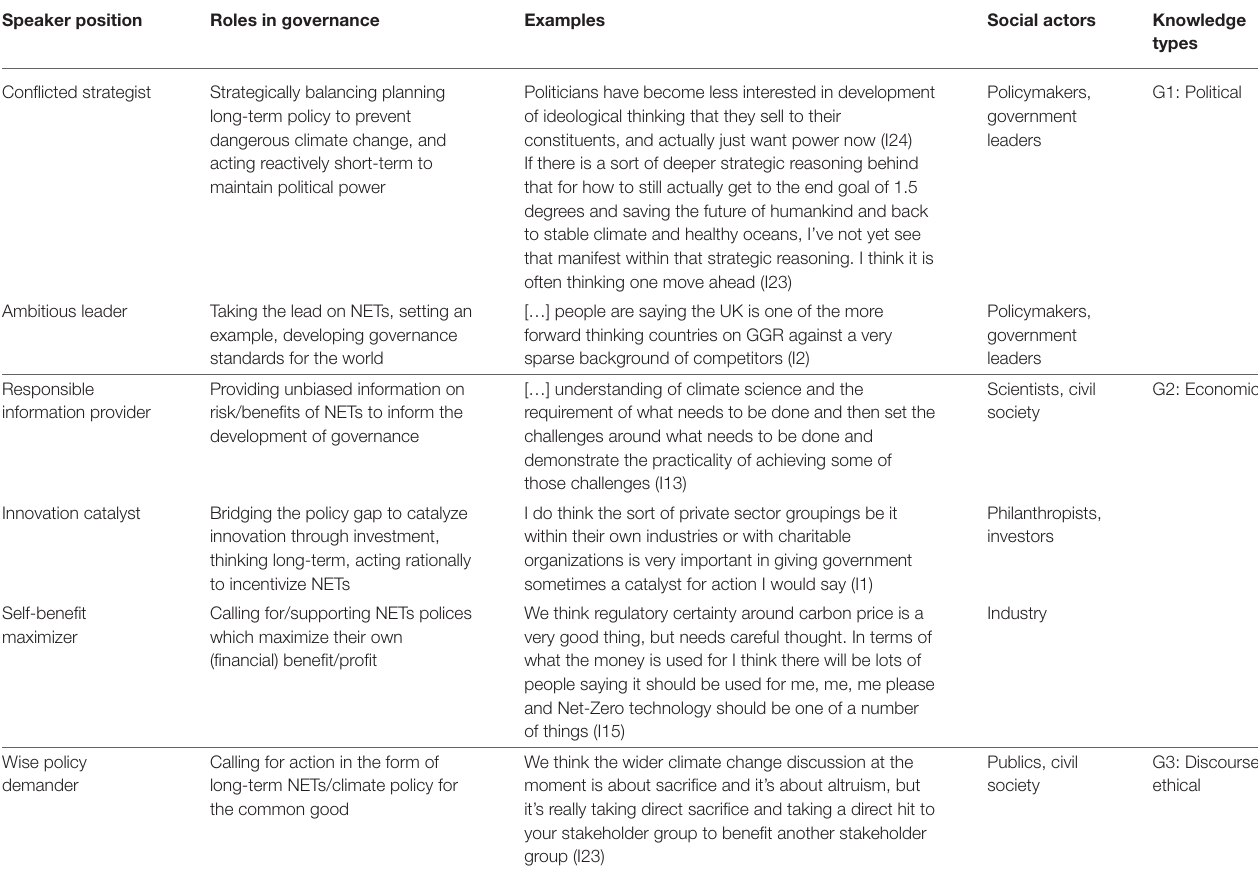
TABLE 4 | Speaker positions (active) offered by discsive